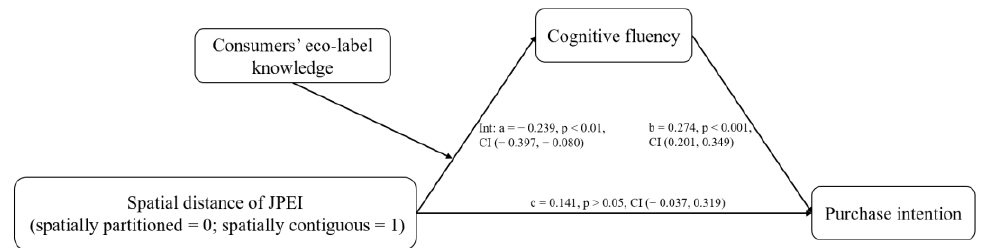
Figure 4. Results for the moderated mediation effect (Study 2).